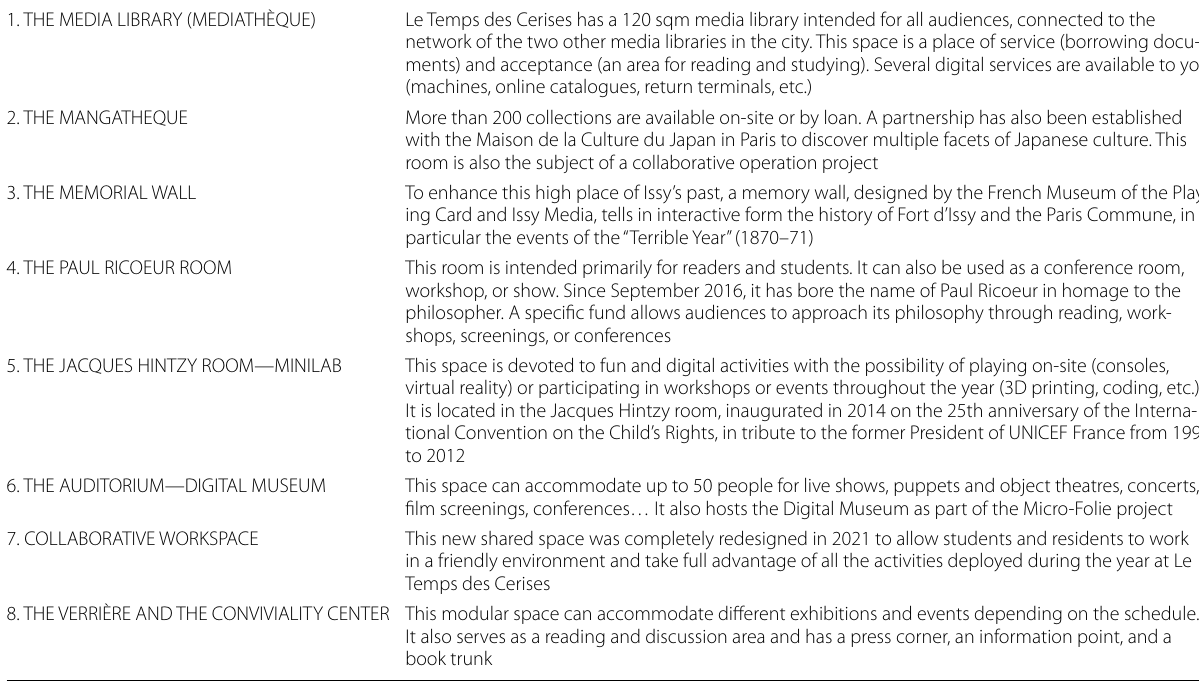
Table 2 Spaces and activities of “Le Temps des Cerises”. Source: CLAVIM